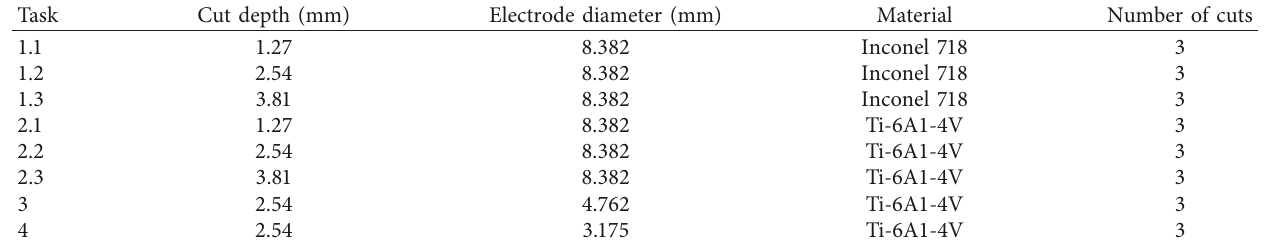
Table 3: Electrode study test matrix.